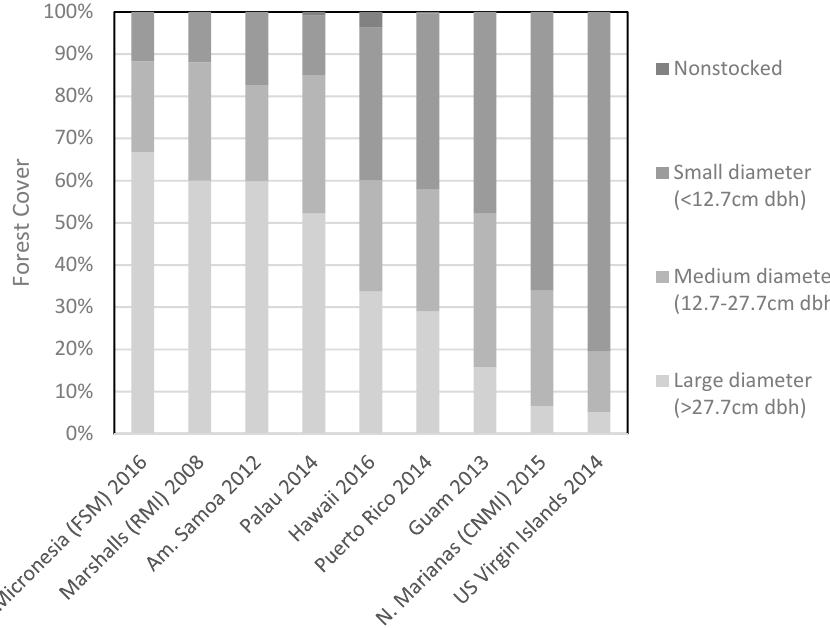
Figure 3. Forest area dominated ( > 50 percent) by large-, medium-, small-diameter, and nonstocked stand classes (FSM: Federated States of Micronesia, CNMI: Commonwealth of Northern Mariana Islands, RMI: Republic of Marshall Islands). Source: [30].